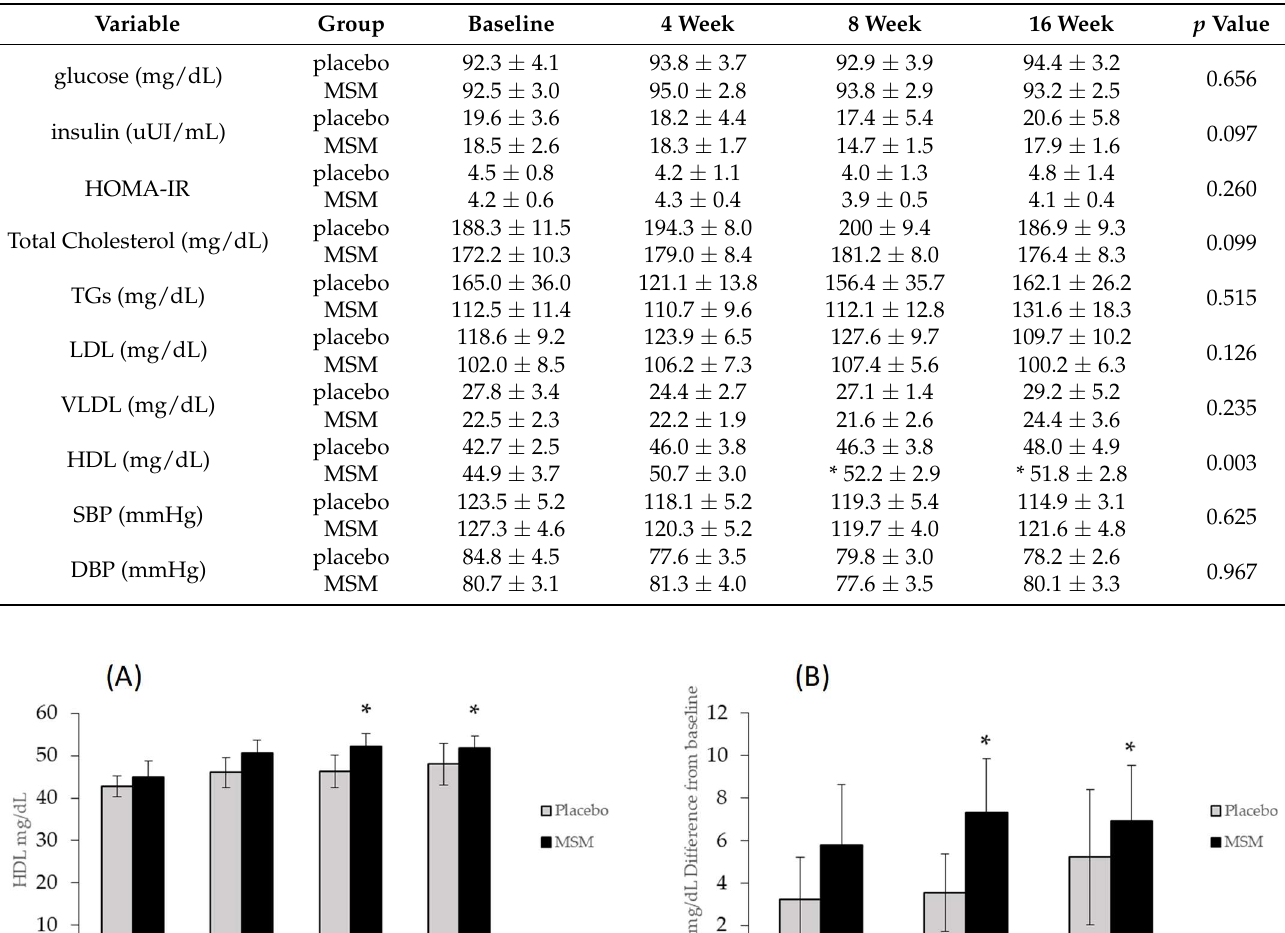
Table 2. Measures of cardiometabolic health. HOMA-IR, Homeostatic model assessment for insulin resistance; TGs, triglycerides; LDL, low-density lipoprotein; VLDL, very-low-density lipoprotein; HDL, high-density lipoprotein; SBP, systolic blood pressure; DBP, diastolic blood pressure. * indicates different from baseline, p ≤ 0.05.